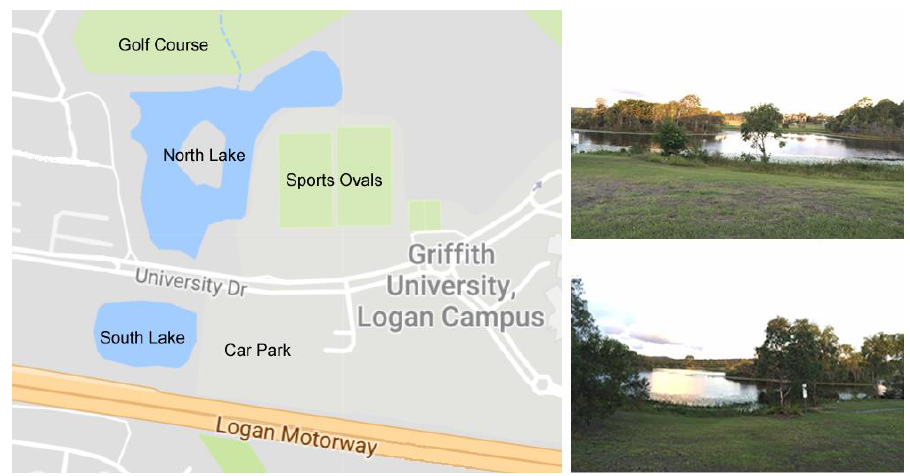
Figure 10. Lake Ellerslie Griffith University Logan Campus.